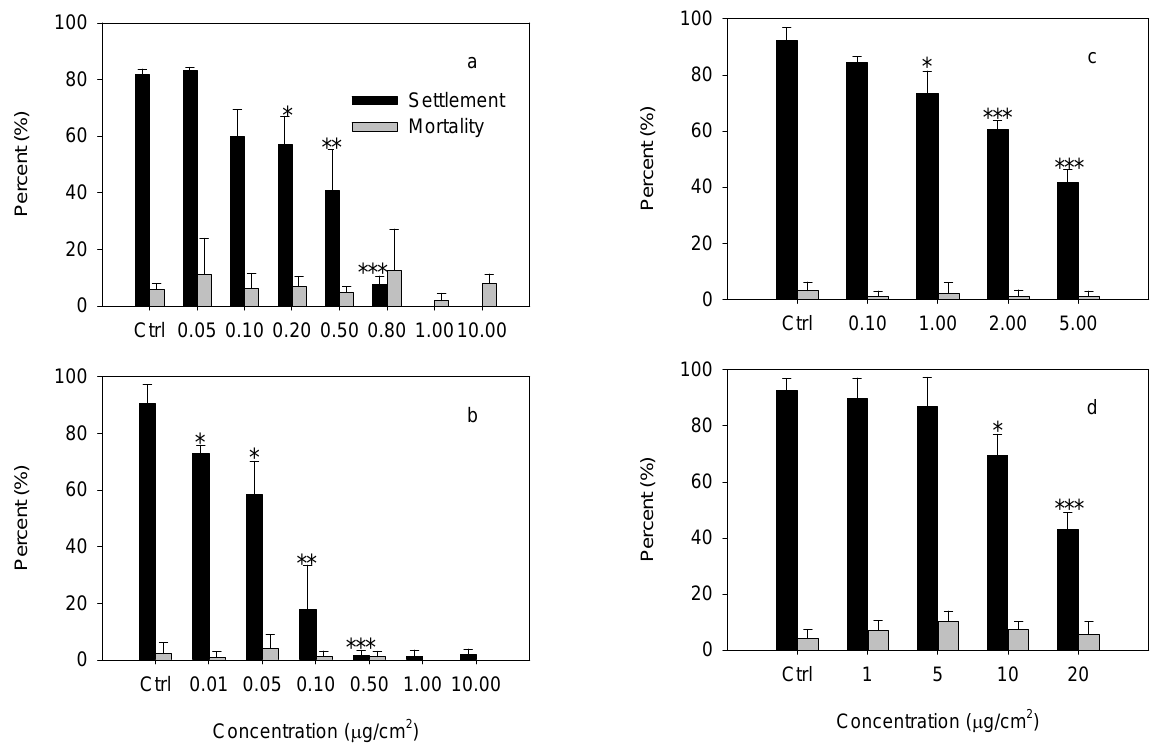
Figure 4. Effects of Compounds 1 - 4 on settlement and survival of cyprid larvae in B. albicostatus . a) Methoxy-ent-8(14)-pimarenely-15-one ( 1 ); b) Ent-8(14)-pimarene- 15 R ,16-diol ( 2 ); c) Stigmasterol (3); d) β -sitosterol (4). Data were analyzed using one- way ANOVA, where * P < 0.05; ** P < 0.01 and *** P < 0.001 were significantly different from the